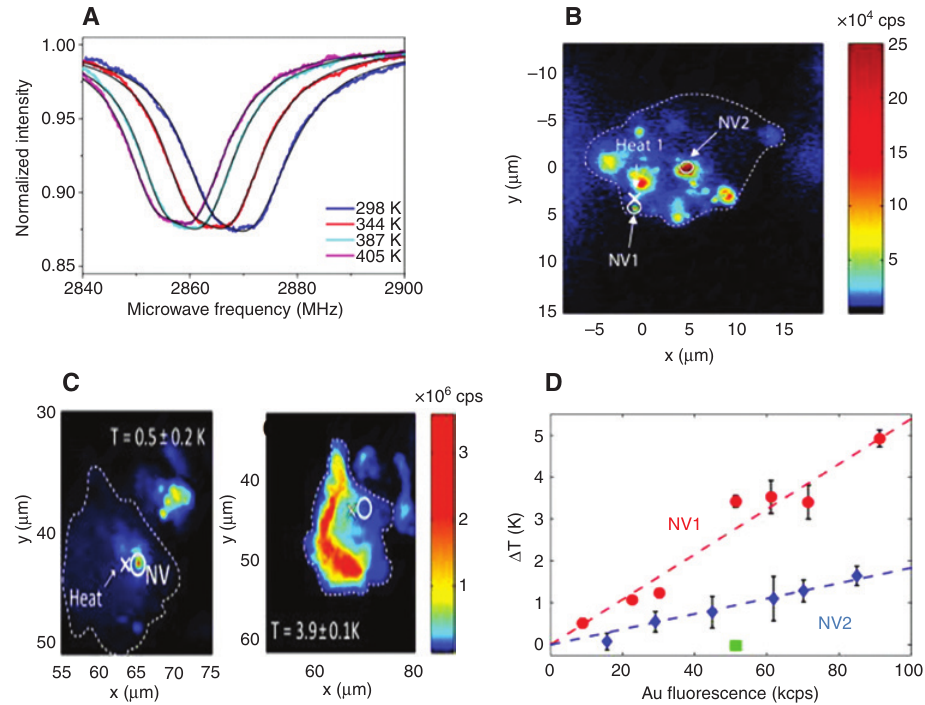
Figure 10: An optical temperature sensing application of FNDs (NV color center) in living cells. (A) ODMR spectra of the NV color center change as a function of local temperature changes [27]. (B) A single living cell injected with fluorescent nanodiamonds and gold nanoparticles (Au NPs) as the heating source and nanoscale thermometer, respectively, followed by excitation under 532 nm. The position of the Au NP is indicated by small cross, while circles represent the location of the NV color centers in nanodiamonds used for thermometry. (C) Measurement of temperature changes precisely as the laser power increases with 0.1 K precision. (D) The change in temperature at the position of NV1 and NV2 relative to the incident laser power applied to the Au NP. Adapted from [120].